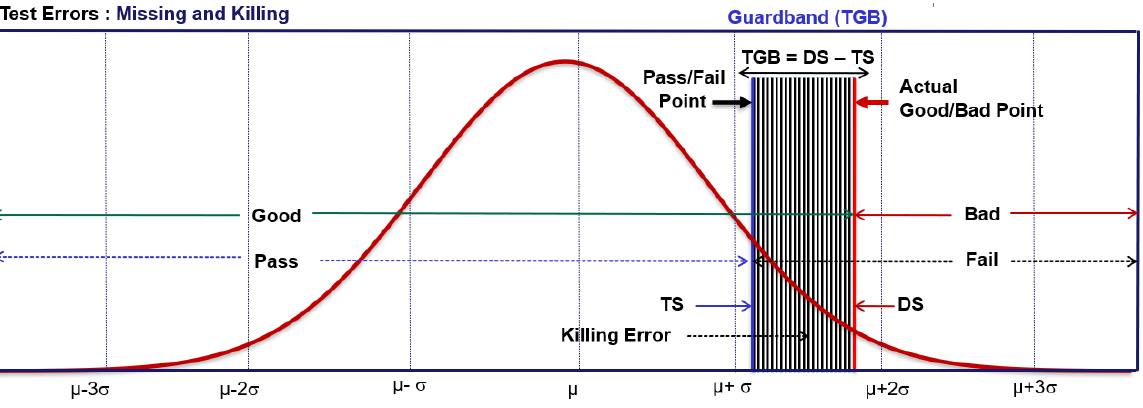
Figure 7. Reduction of error occurrence by traditional guardband movement. Table 2. The impact of test parameters OTA and test specifications on test results.